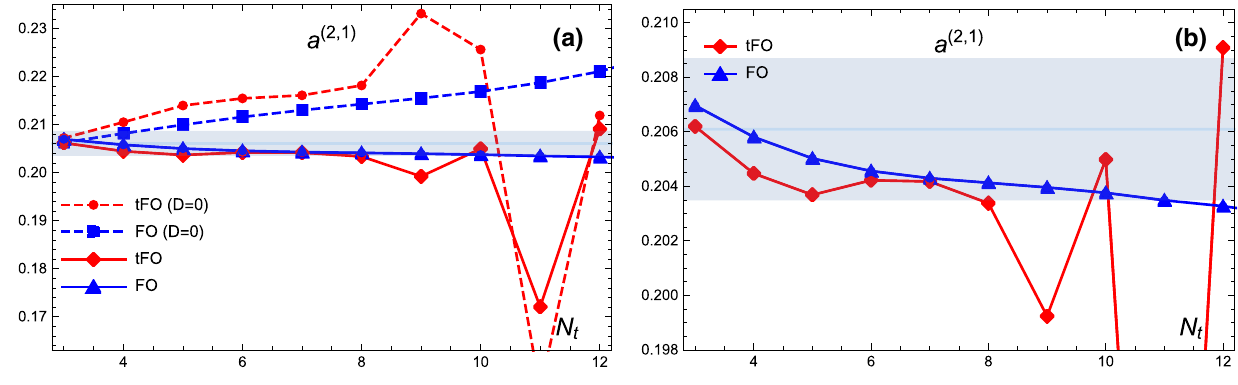
Fig. 9 The same as in Fig. 8, but for the moment a ( 2 , 1 ) (σ m ) ( = r τ (σ m ) ( D = 0 ) )